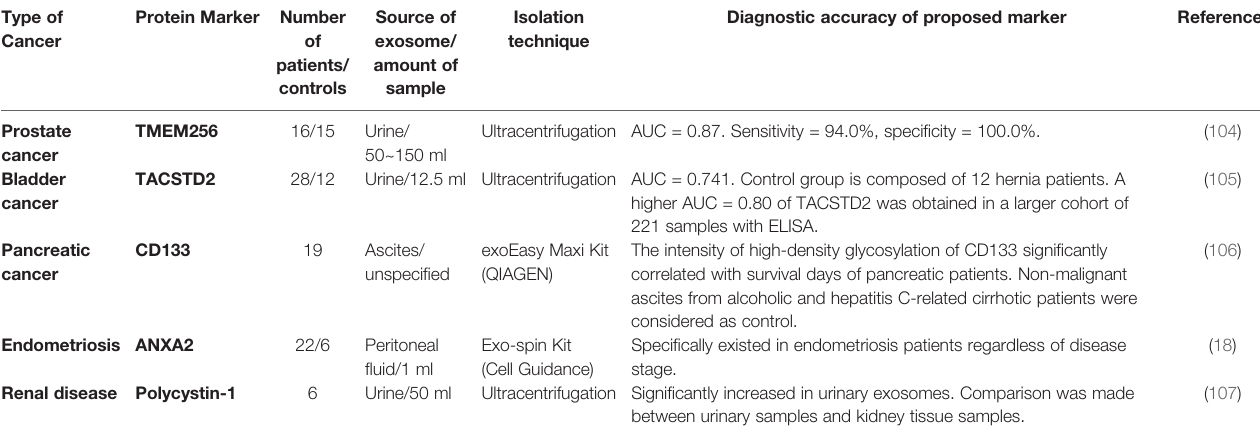
TABLE 6 | Tumor-associated exosomal protein in urine and